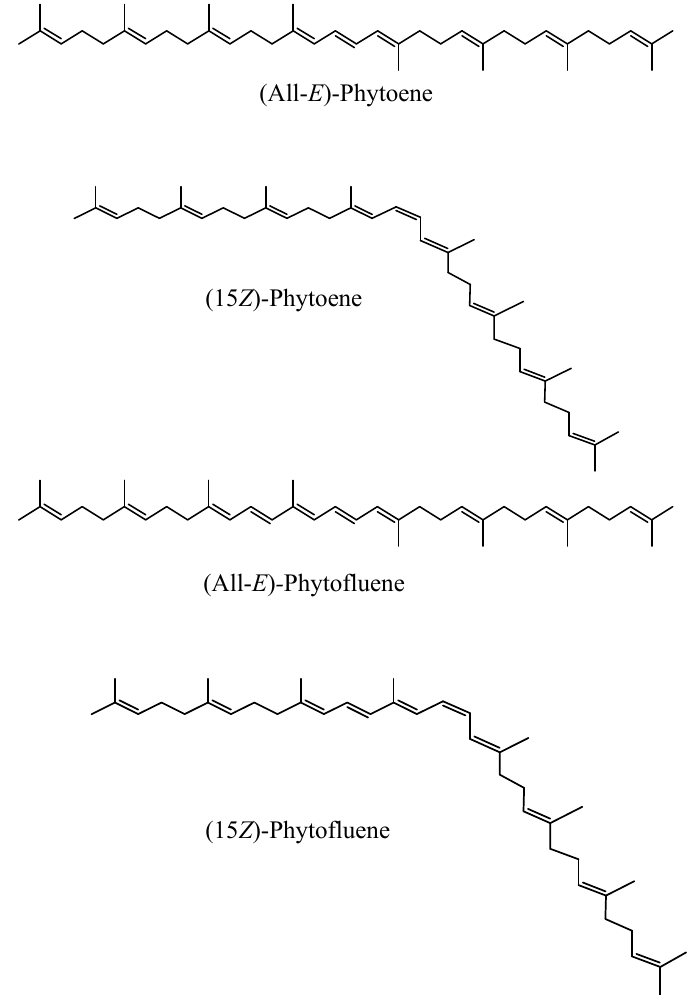
Figure 5. Chemical structures of (all- E )- and (15 Z )-isomers of phytoene and phytofluene.